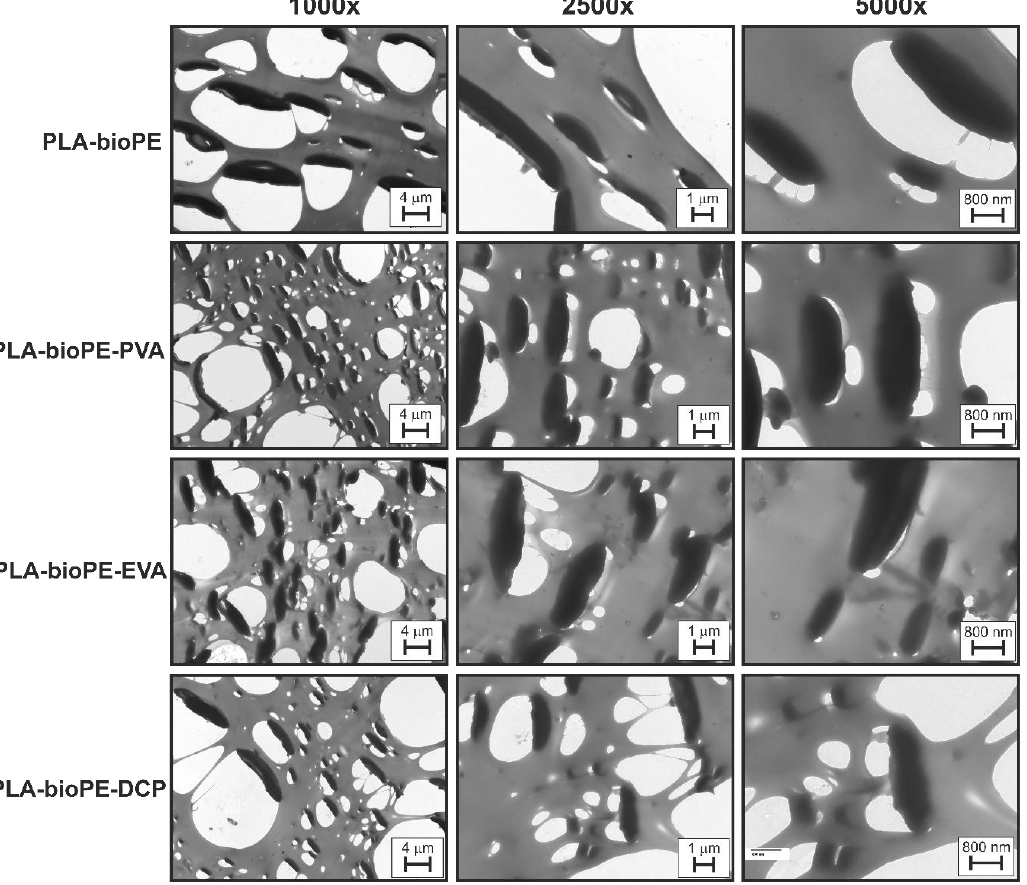
Figure 6. Transmission Electron Microscopy (TEM) micrographs at 1000×, 2500×, and 5000× of the PLA-bioPE blend and PLA-bioPE blend compatibilized with PVA, EVA, and DCP.